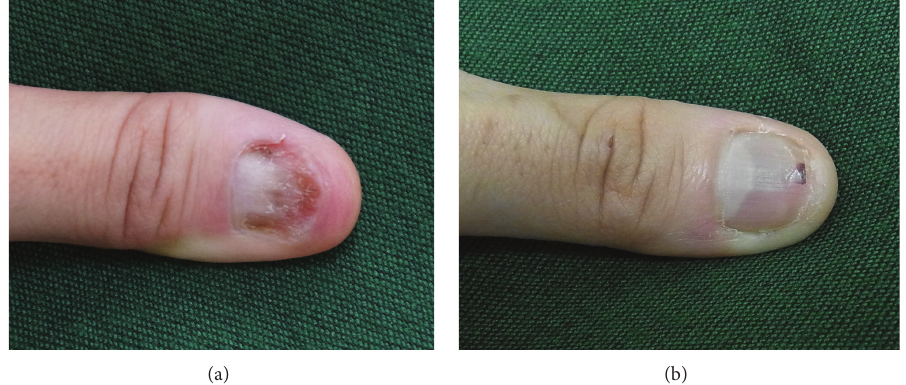
Figure 2: Left thumbnail one month after starting the external use of bFGF (a), and three months subsequently